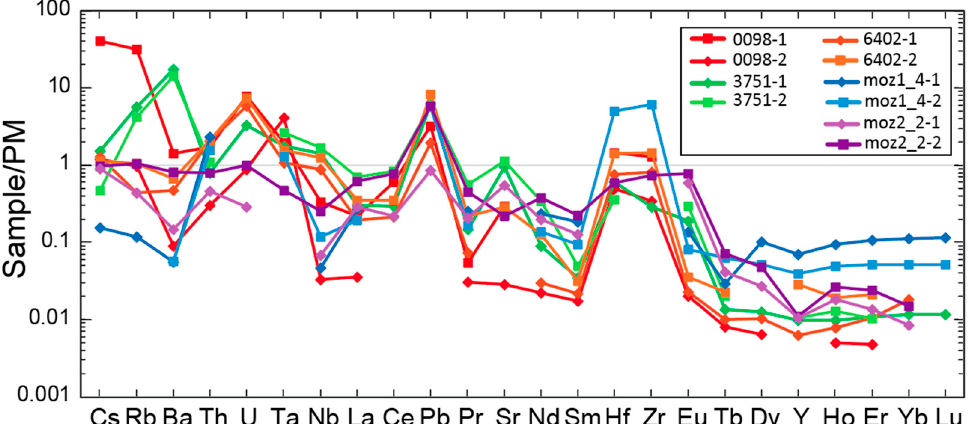
Figure 6. Primitive mantle-normalized [58] trace element concentrations of duplicate offline-ablations for five samples in this study. Lines of the same color denote replicate analyses of the same sample in a different area of the crystal. Sample 0098 is from the Mogok Stone Tract, Myanmar; samples 3751 and 6402 are from the Morogoro region in Tanzania; and samples moz1_4 and moz2_2 are from the Montepuez area in Mozambique.